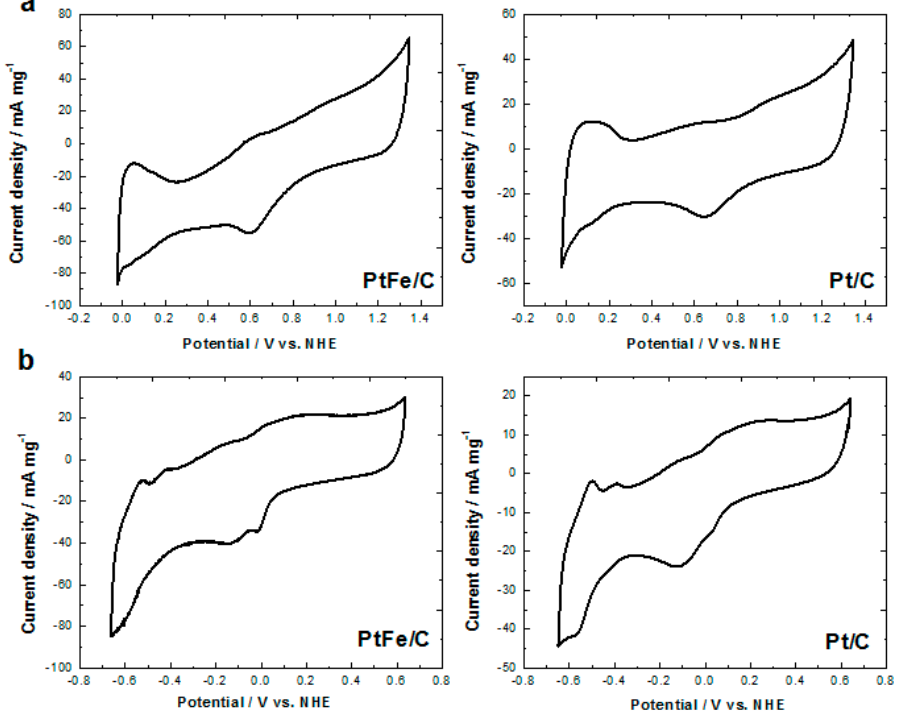
Figure 5. Cyclic voltammograms for PtFe/C and Pt/C in ( a ) 0.5 M H 2 SO 4 as an acidic electrolyte and ( b ) 0.3 M KOH as an alkaline electrolyte. Scan rate: 50 mV·s − 1 .